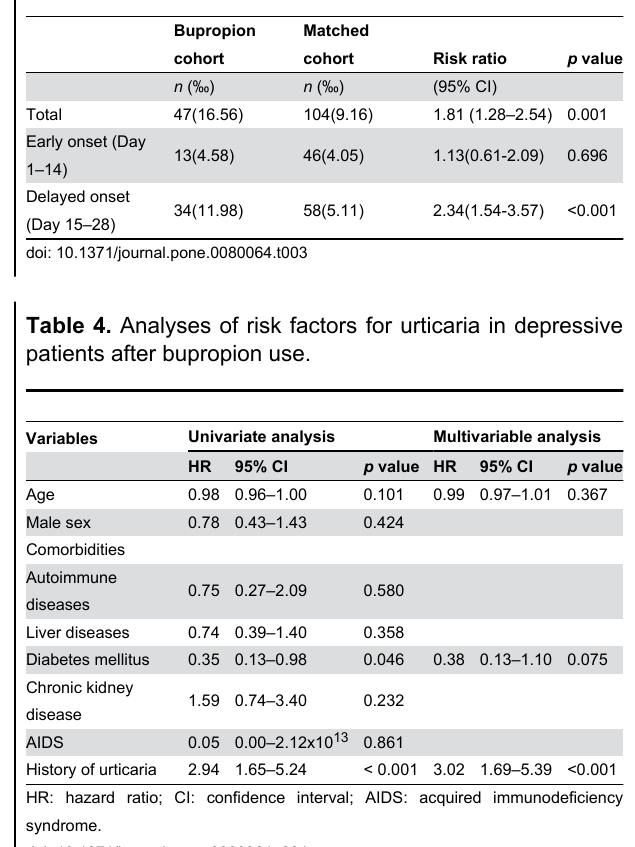
Table 3. Comparisons of early and delayed onset urticaria occurrence.